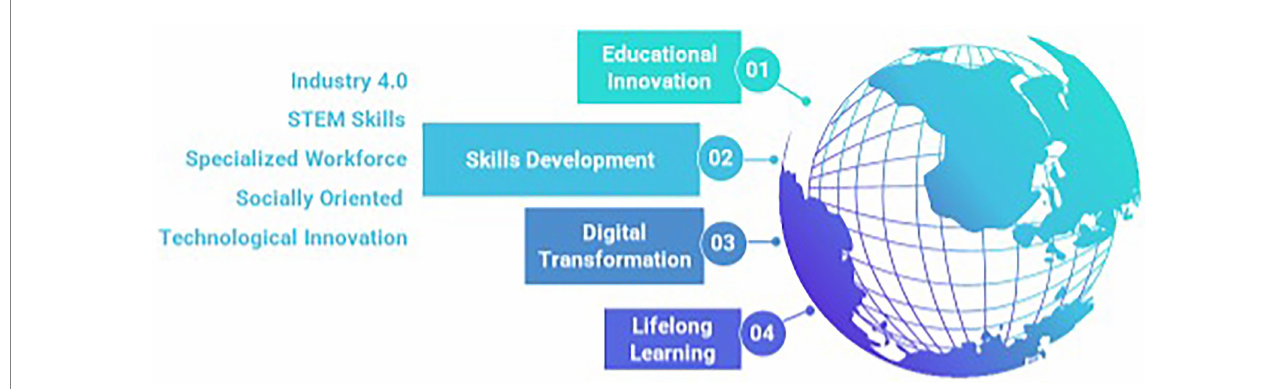
FIGURE 9 Education, Skills, and Learning Model for a KBUD Innovation District. Own elaboration based on the Education 2030 Report (OECD).